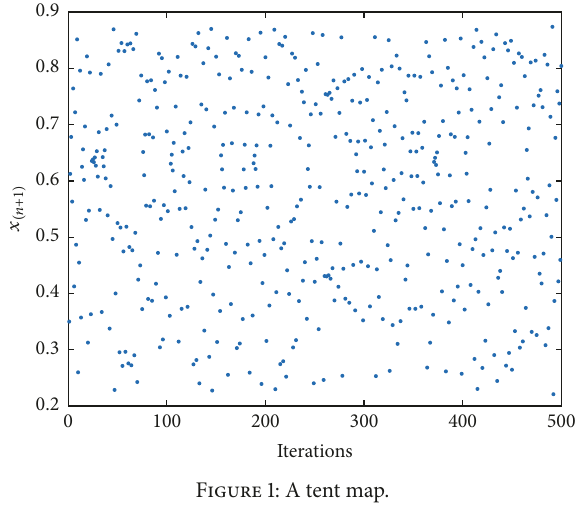
Figure 1: A tent